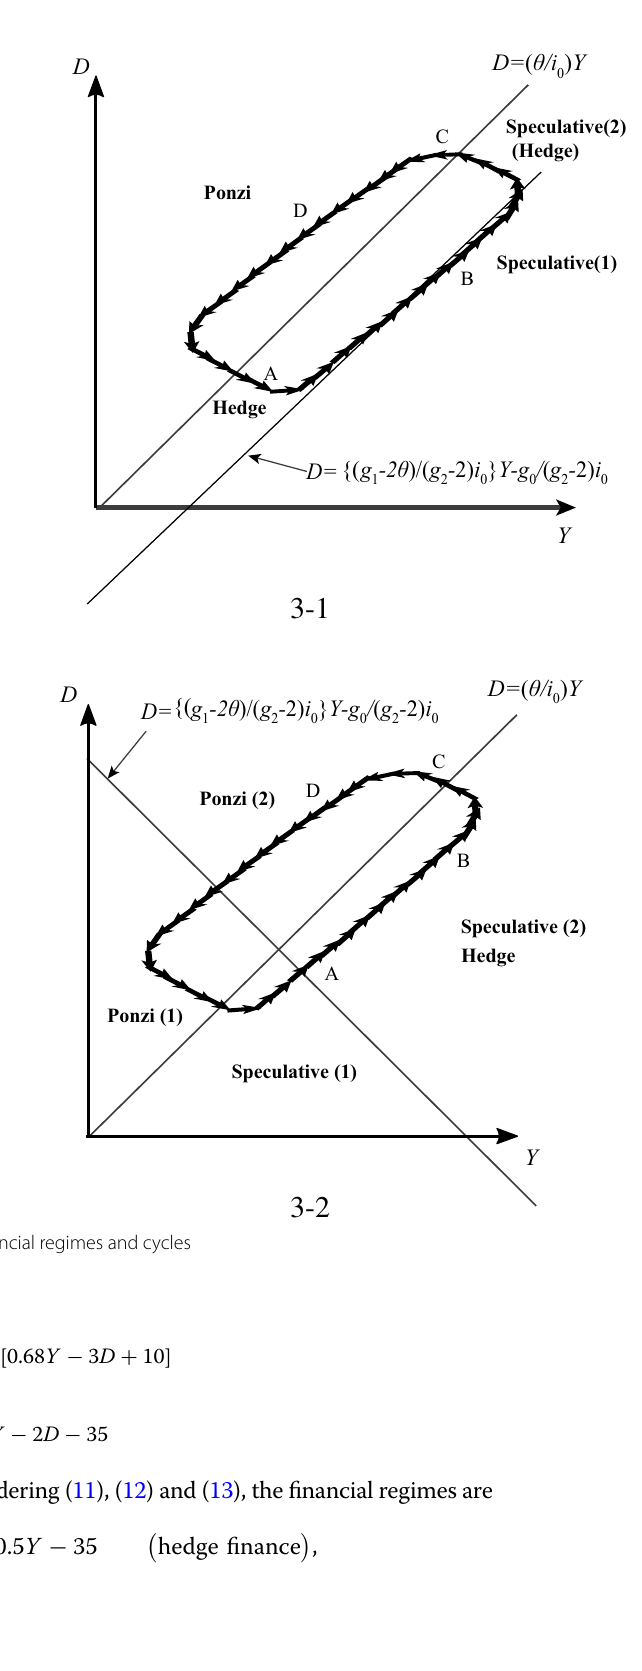
Fig. 3 Financial regimes and